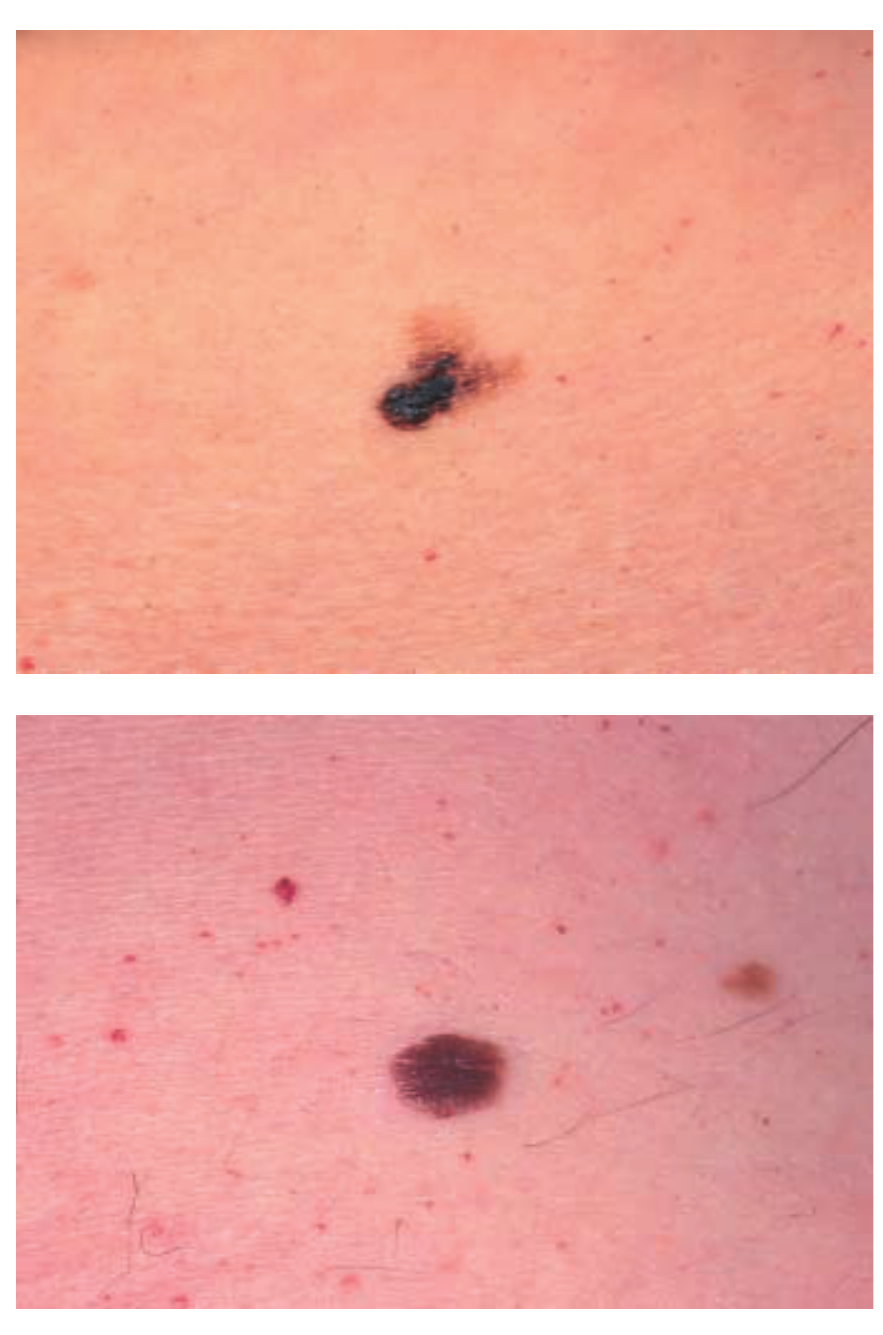
Figure 1 Clinical presentation of a malignant melanoma.